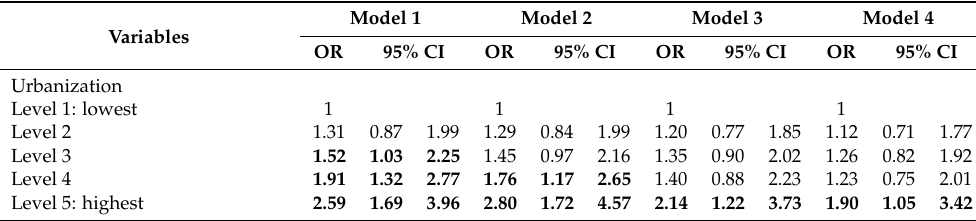
Table 5. Factors associated with the recommended amount of PA*: multi-level